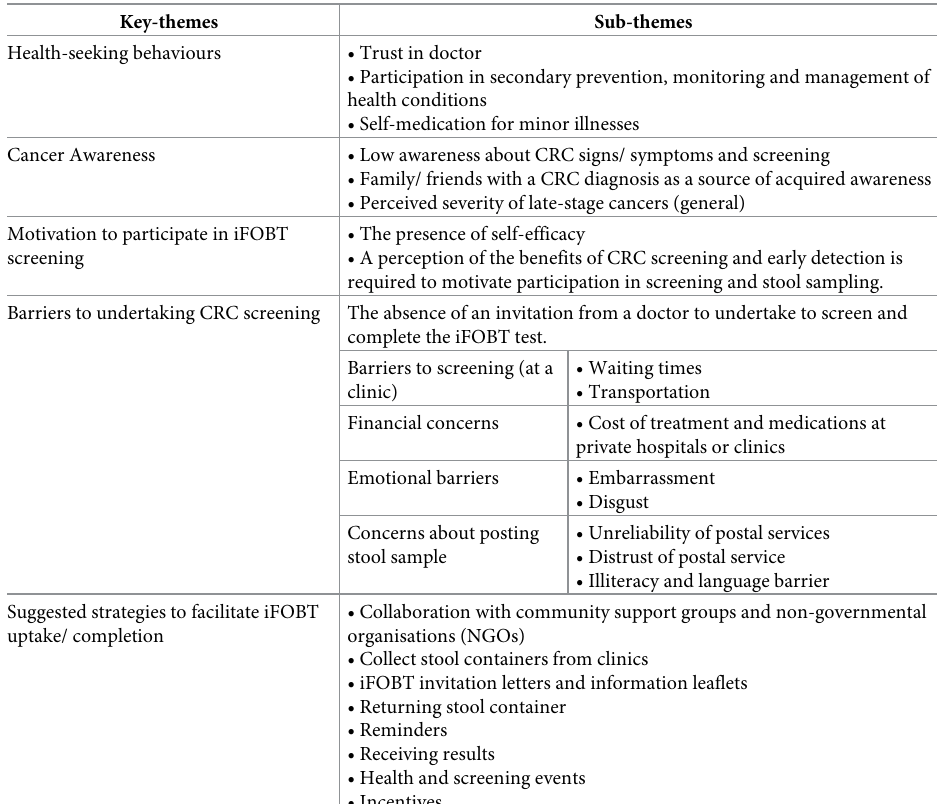
Table 2. Key-themes and